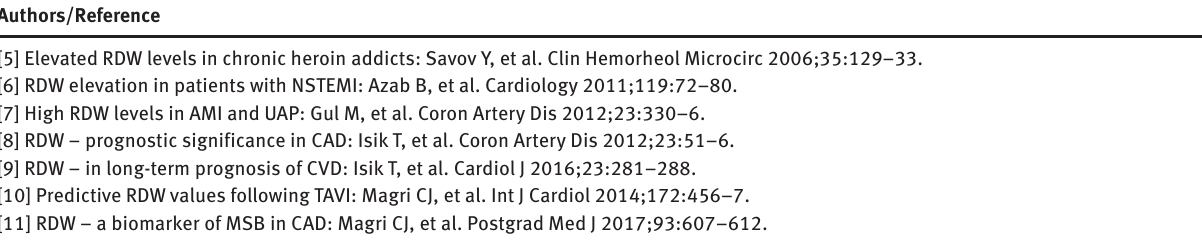
Table 1: Pioneering studies of clinical significance and prognostic values of increased red blood cell distribution width (RDW) as biomarker in cardiovascular, brain vascular and peripheral vascular